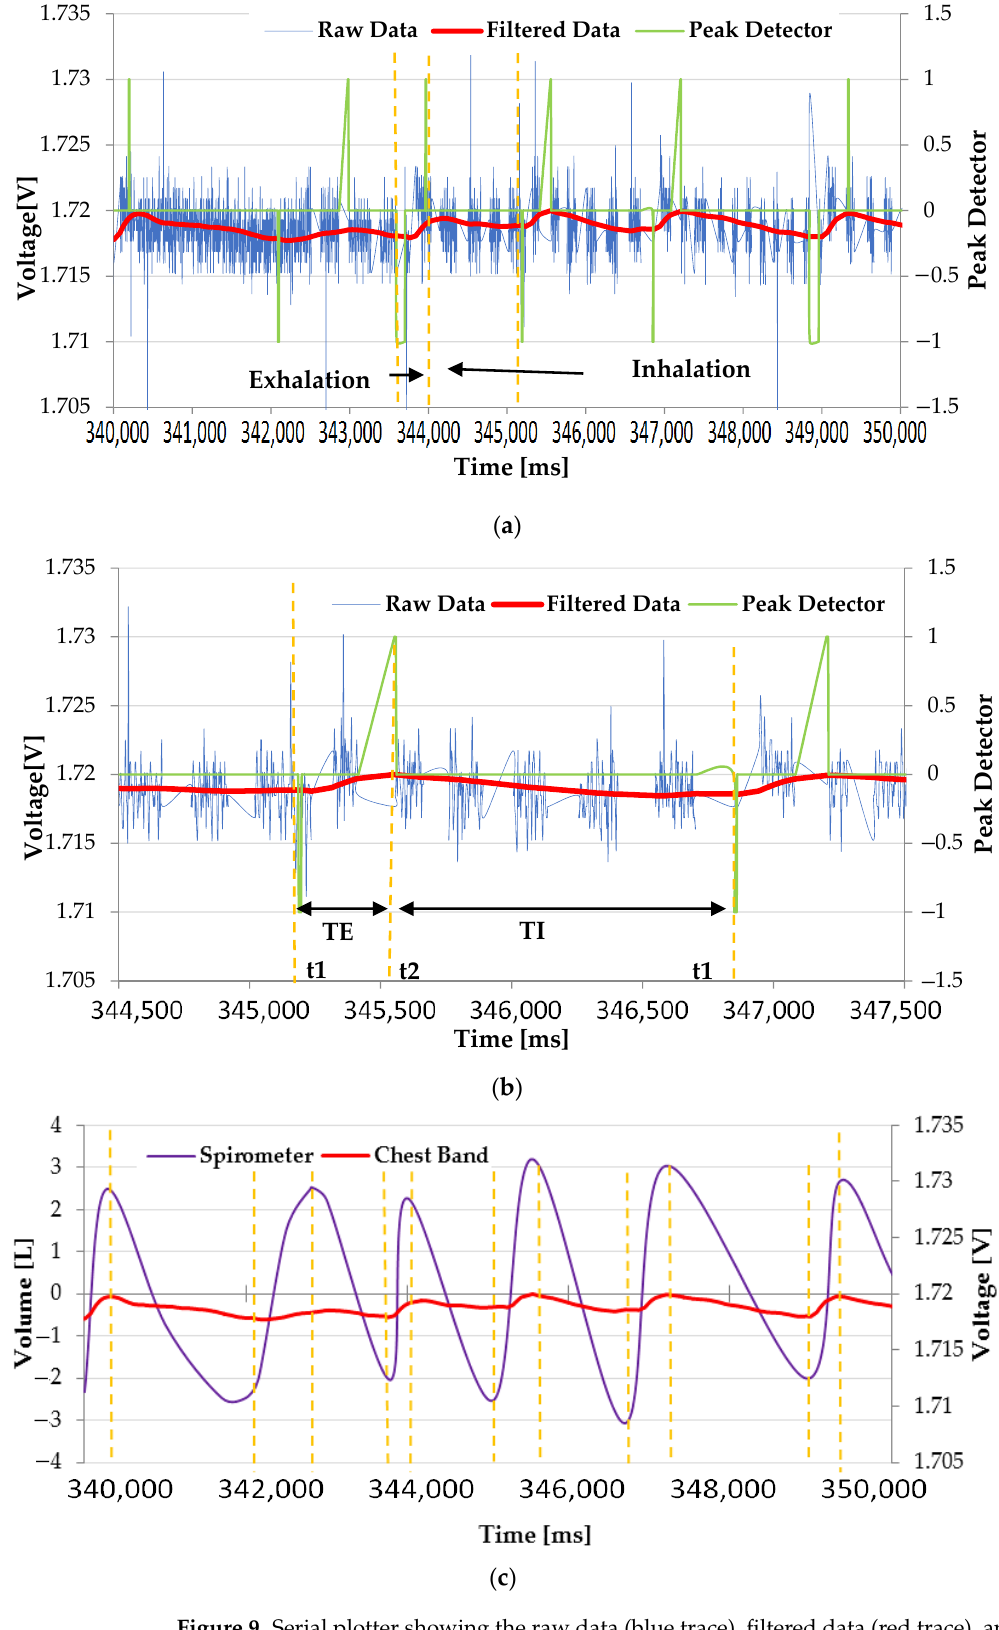
Figure 9. Serial plotter showing the raw data (blue trace), filtered data (red trace), and peak detector output (green trace): wide ( a ) and detailed ( b ) views, highlighting the inspiration and expiration phases. Reference volume vs. time trend acquired by a spirometer ( c ).